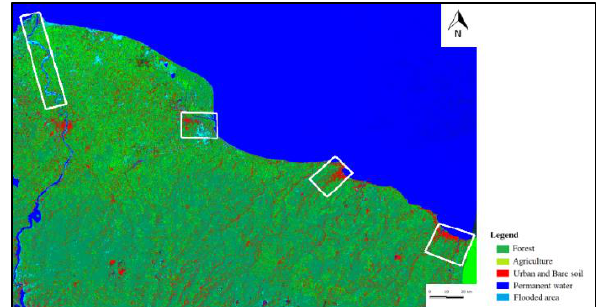
Figure 12. Result of the flood analysis produced for the whole study area.